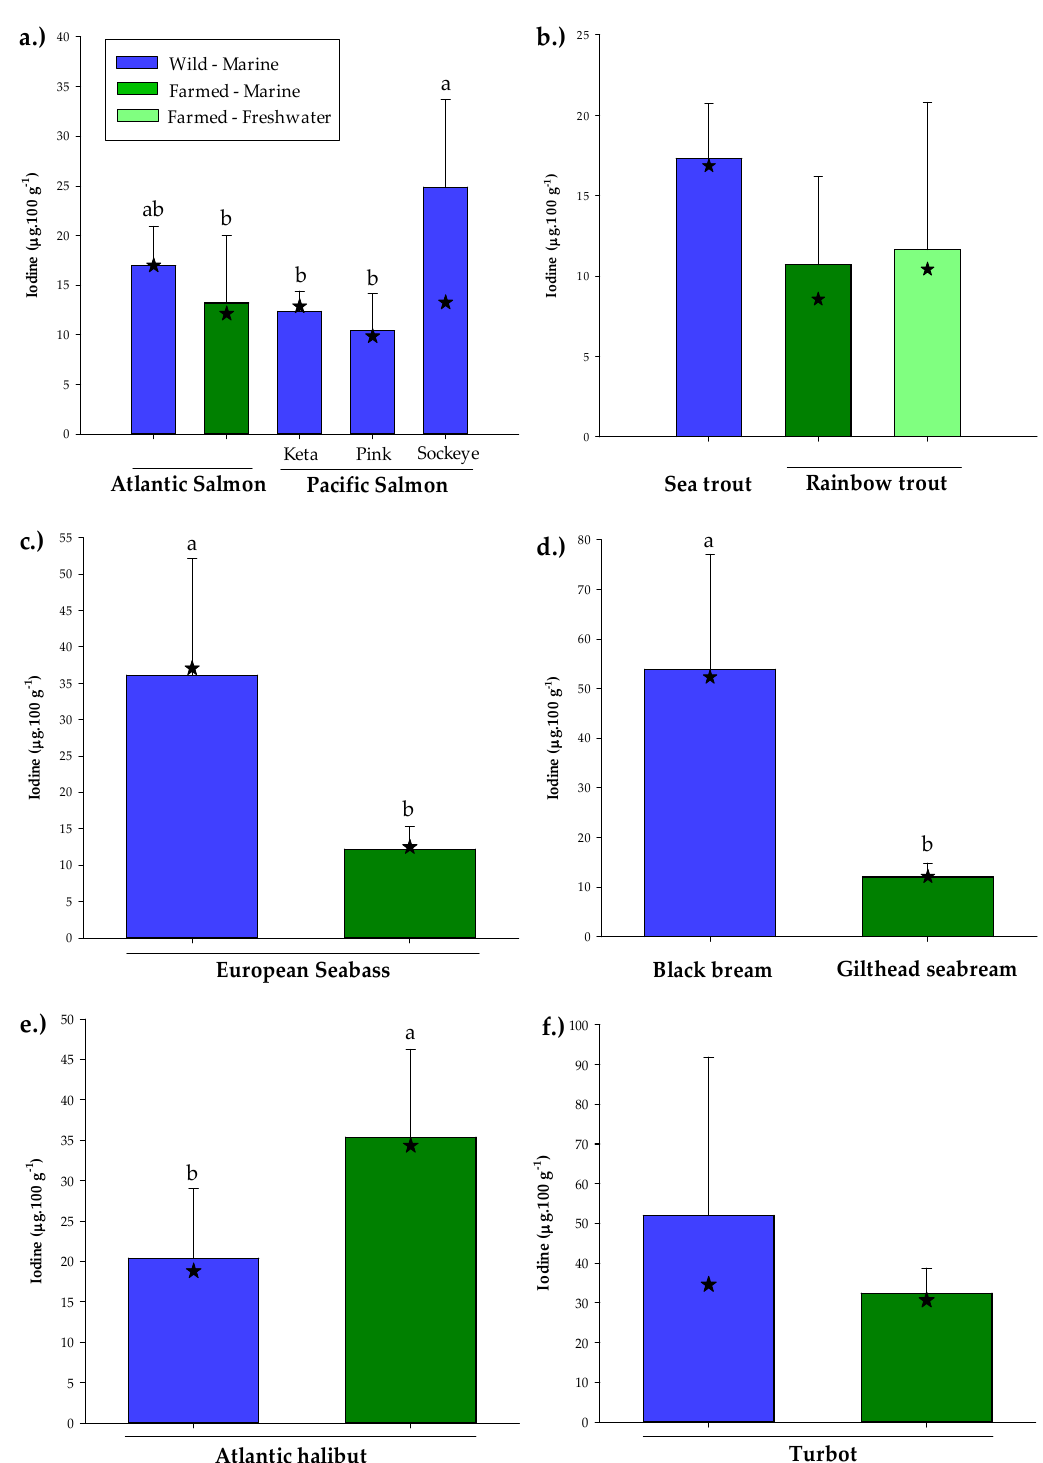
Figure 2. Comparison of iodine contents (µg·100 g −1 flesh, ww, mean ± SD) between wild fish and their respective farmed counterparts; ( a ) Atlantic and Pacific salmon, ( b ) sea trout and rainbow trout, ( c ) European seabass, ( d ) black and gilthead seabream, ( e ) Atlantic halibut, ( f ) turbot. Bars bearing different lettering within same species graphs indicate a significant difference ( p < 0.05). (cid:70) indicates median iodine value. Note that scaling for iodine contents differs between species graphs.